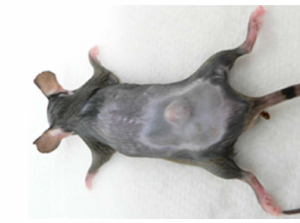
Figure 7. Mouse with subcutaneous SCCVII tumor growing in lower